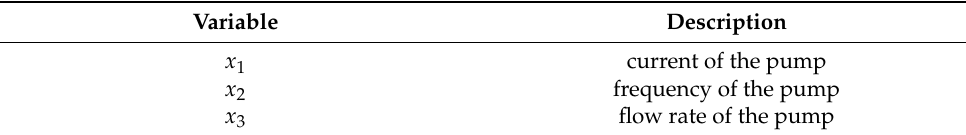
Table 1. Auxiliary variables used in the soft sensing models.